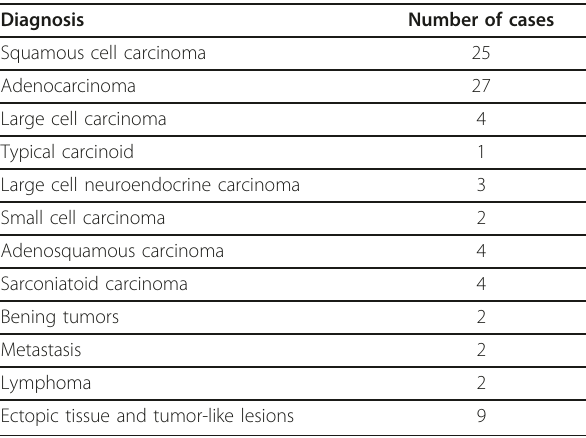
Table 2 Types f pathological change diagnosed in